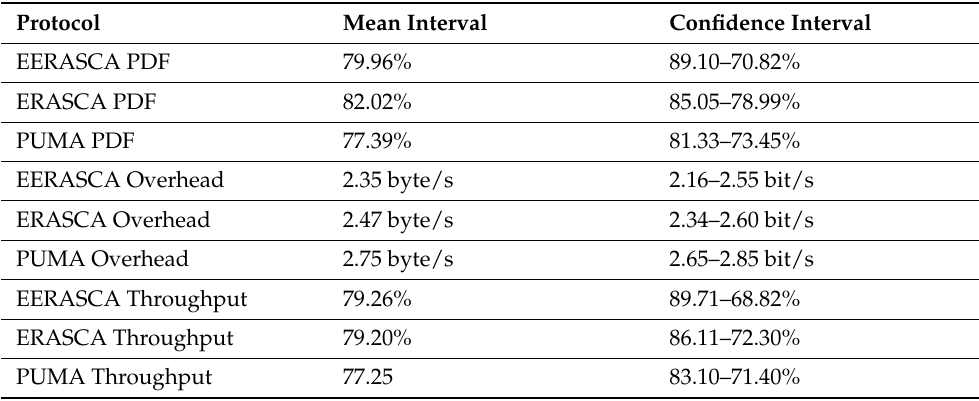
Table 3. Confidence Interval for PDF, Overhead and Throughput.